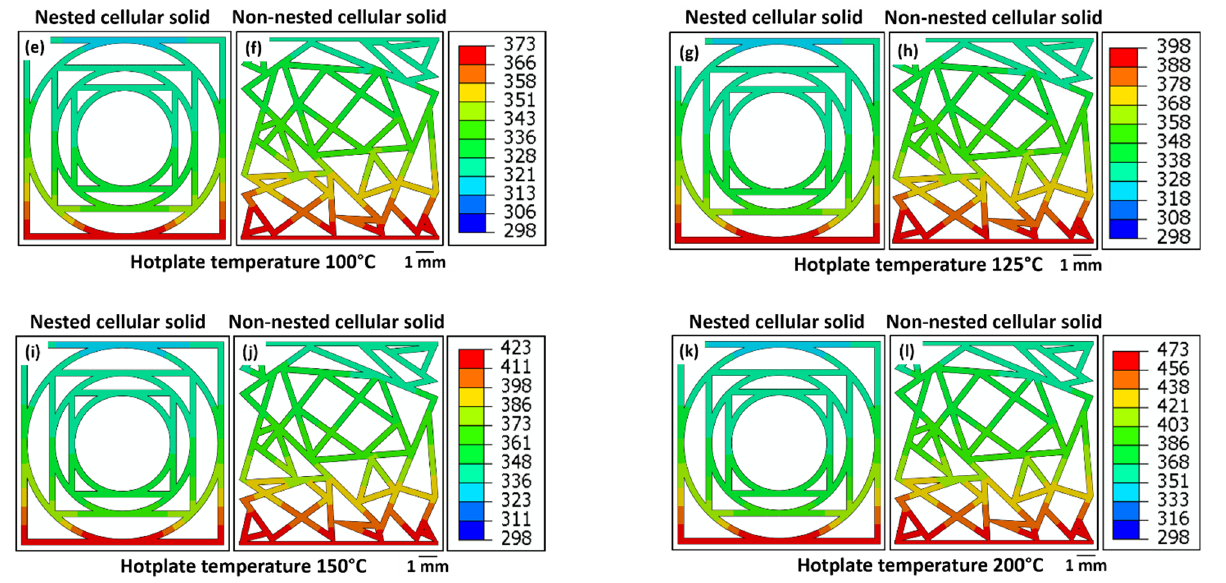
Figure 11. Simulated temperature distribution of the ( a , c , e , g , i , k ) nested and ( b , d , f , h , j , l ) non-nested cellular solids for hotplate temperature ( a , b ) 50 °C; ( c , d ) 75 °C; ( e , f ) 100 °C; ( g , h ) 125 °C; ( i , j ) 150 °C; and ( k , l ) 200 °C. The legend in Figure 11 shows the temperature in Kelvin.